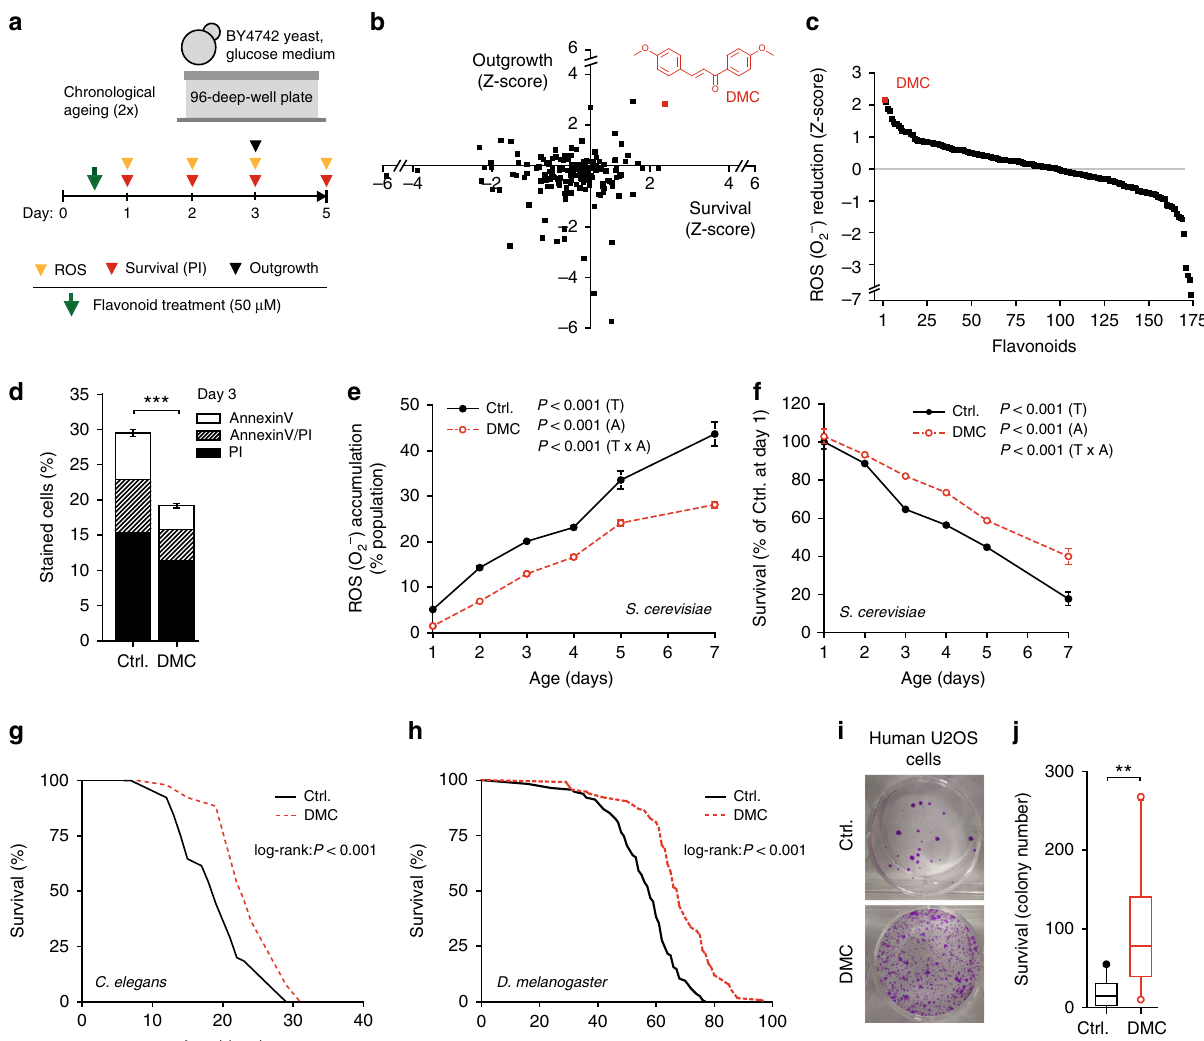
Fig. 1 4,4 ′ -dimethoxychalcone promotes longevity in yeast, nematodes, fl ies and human cells. a Screening procedure for anti-ageing fl avonoids in a yeast chronological ageing model. b , c Z -scores of AUCs obtained for each fl avonoid during the yeast screen and for each assay performed: PI staining, outgrowth capacity ( b ), and DHE to ethidium conversion ( c ); data obtained in 1 – 2 independent runs with three replicates each. Each data point represents one fl avonoid. The data point and the structure of 4,4 ′ -dimethoxychalcone (DMC) are shown in red. d – f Phosphatidylserine externalisation and membrane dysintegrity ( d ), ROS production ( e ) and survival ( f ) of DMC-treated yeast cells (100 µ M) at indicated time points of chronological ageing using AnnexinV/PI costaining ( d ), *** P < 0.001, n = 18, DHE to ethidium conversion, n = 6 ( e ) and clonogenicity, n = 8 ( f ) independent biological replicates; P -values represent T, treatment; A, age; T ×A, interaction. g , h Survival of C. elegans ( g ) or D. melanogaster ( h ) during ageing with supplementation of food with DMC (41.6 µ M for worms, 200 µ M for fl ies). For other ageing replicates, see Supplementary Figure 2 (yeast) and 3 (nematodes, fl ies). i , j Replicative viability of DMC-treated (50 µ M) U2OS cells. Representative images ( i ) and quanti fi cation ( j ) are shown, ** P = 0.0069, n = 11 independent biological replicates. Data in ( d ) represent means ± SEM; box plots in ( j ) represent IQR (line at median) and whiskers 10 – 90 percentile. Signi fi cance in ( d , j ) was assessed by two-sided Student ’ s t -test, in ( e , f ) by repeated measures two-way ANOVA. Source data for ( b – f , j ) are provided as a Source Data fi